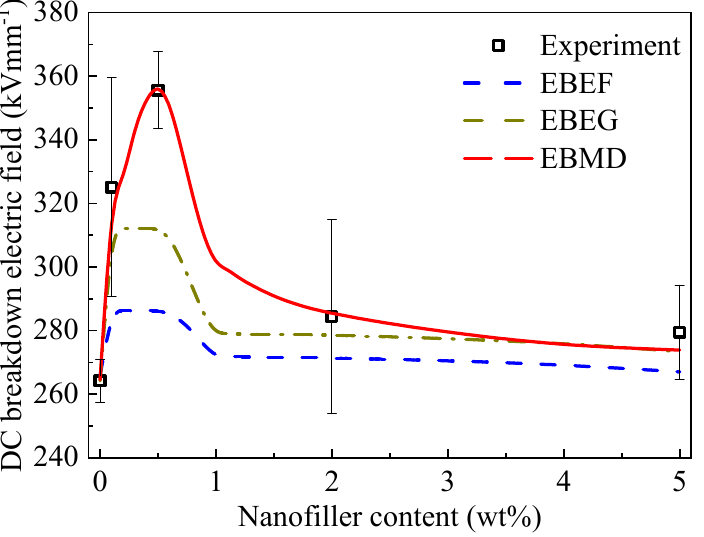
Figure 8. Comparison of EBEF, EBEG, and EBMD simulation electrical breakdown fields with experimental results.